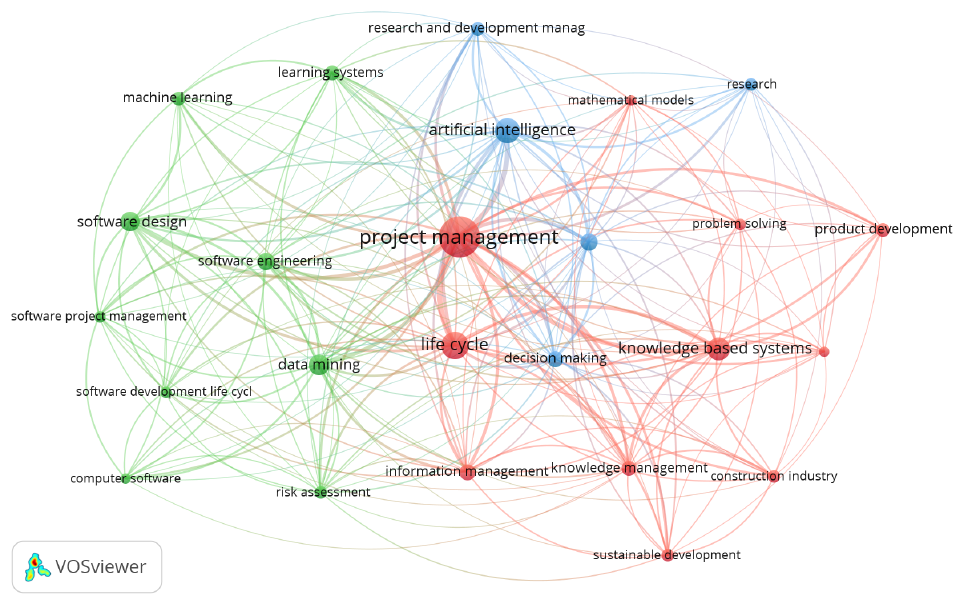
Figure 6. Clusters identified in the Life Cycle